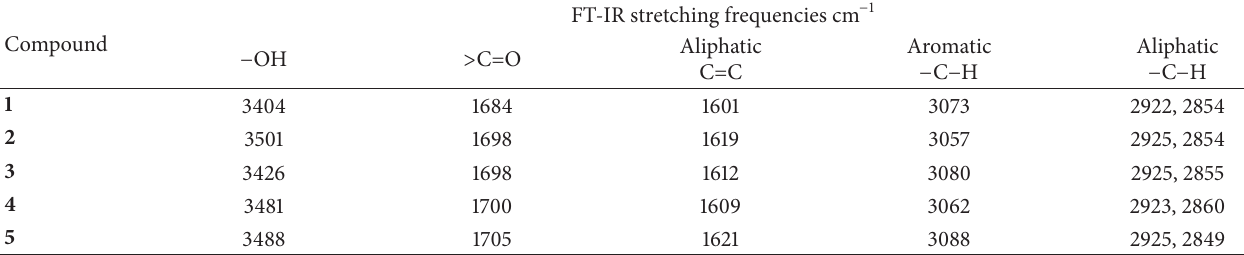
Table 2: FT-IR stretching frequencies for selected functional groups and UV-vis absorption band of curcumin analogues 1 – 5 . Compound